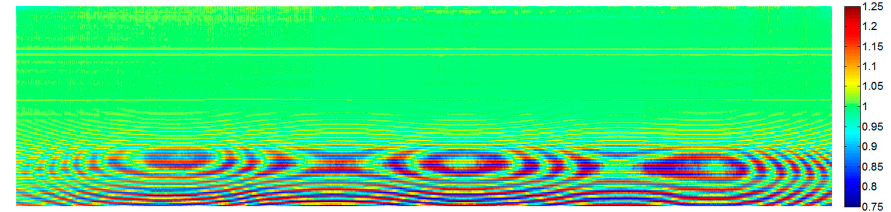
Figure 4. The fringe amplitude image of the calibration data.